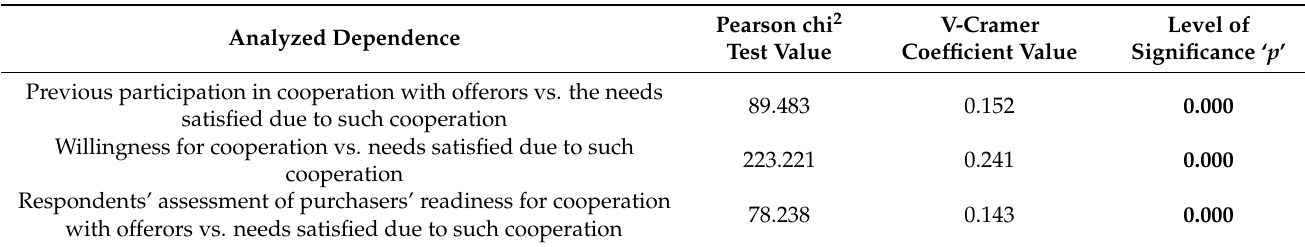
Table 5. Analysis of dependencies between respondents’ attitudes toward co-creation of marketing offers with offerors and the needs satisfied due to such cooperation.